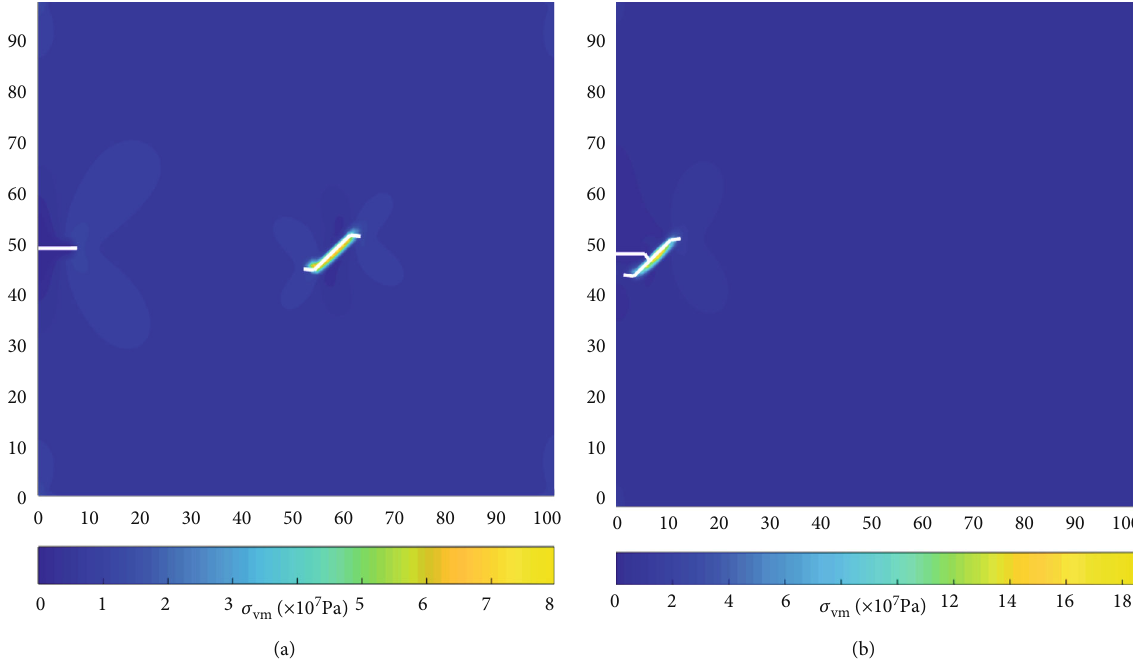
Figure 11: Shaded plots of the von Mises stress σ vm for the two-crack example: (a) case 3; (b) case 4 (lengths in